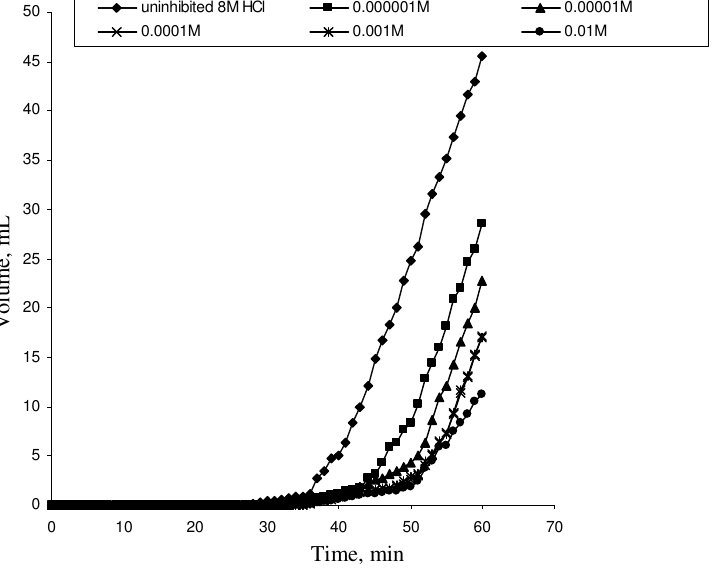
Figure 8. Variation of volume of hydrogen gas evolved with time (min) for the inhibition of mild steel in 8 M HCl solutions by 2-benzoylpyridine at 303K.